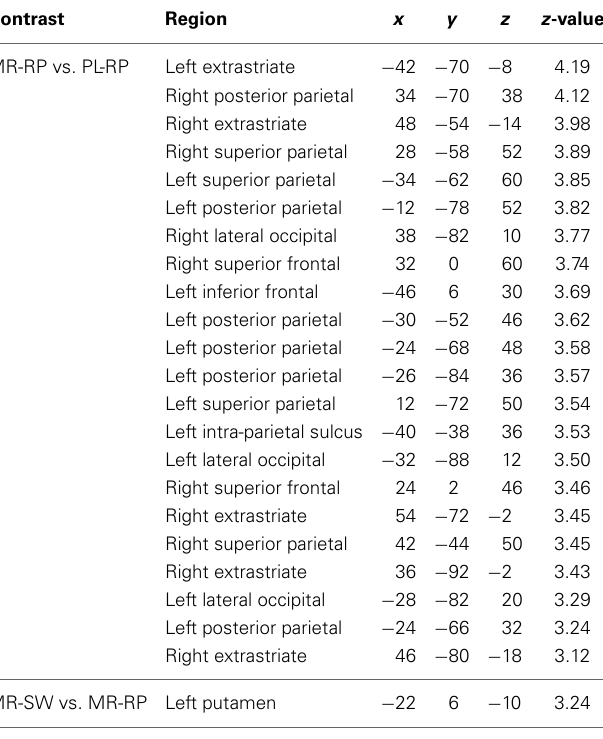
Table 2 | Brain regions showing significant univariate activation decrease after behavioral